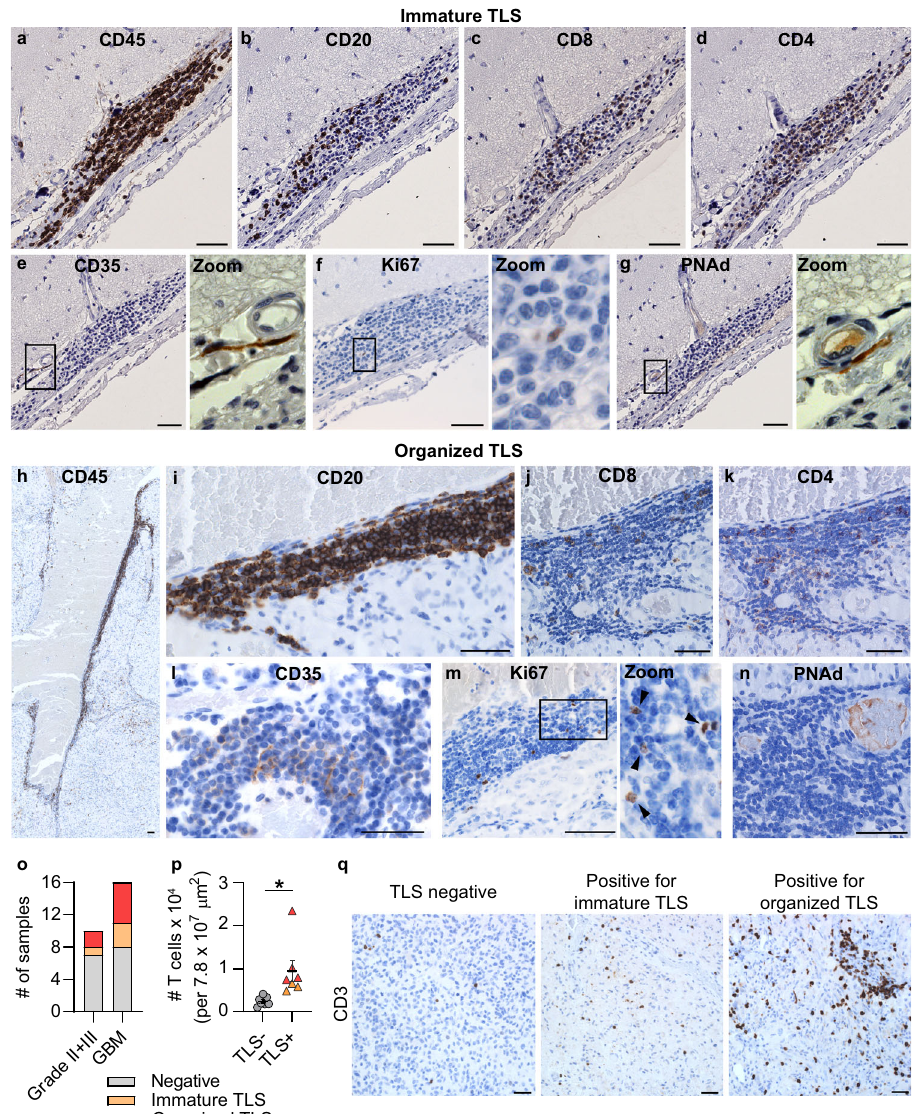
Fig. 3 Tertiary lymphoid structures were present in the brain of glioma patients and were associated with increased T cell abundance. Immunohistochemical stainings of human glioma sections showing the composition of ( a – g ) immature TLS characterized by a loose B cell core and ( h – n ) organized TLS characterized by a compact core of B cells. Black square areas in e – g and m are magni fi ed to the right of each image. Scale bars: 50 µ m. a , b Representative of 21 immature TLS. h , i Representative of 16 organized TLS. Stainings in c – g and j – n were performed on one representative immature TLS and one representative organized TLS. o Number of grade II/grade III glioma patients and glioblastoma (GBM) patients included in our cohort that stained negative for TLS (gray), positive for immature TLS (orange) or positive for organized TLS (red). n (Grade II + III, negative) = 7, n (Grade II + III, immature TLS) = 1, n (Grade II + III, organized TLS) = 2, n (GBM, negative) = 8, n (GBM, immature TLS) = 3, n (GBM, organized TLS) = 5. p Number of T cells in fi ltrating the tumor area in GBM patients negative for TLS (gray circle) versus GBM patients positive for TLS (orange triangle: immature TLS; red triangle: organized TLS). n = 7 patients/group. p = 0.0142. Two- tailed t -test. Bars: mean ± SEM. q Representative images of T cell in fi ltration in GBMs that were negative for TLS, positive for immature TLS or positive for organized TLS. Scale bars: 50 µ m. For all graphs in this fi gure, * p <0.05. Source data are provided as a Source Data fi